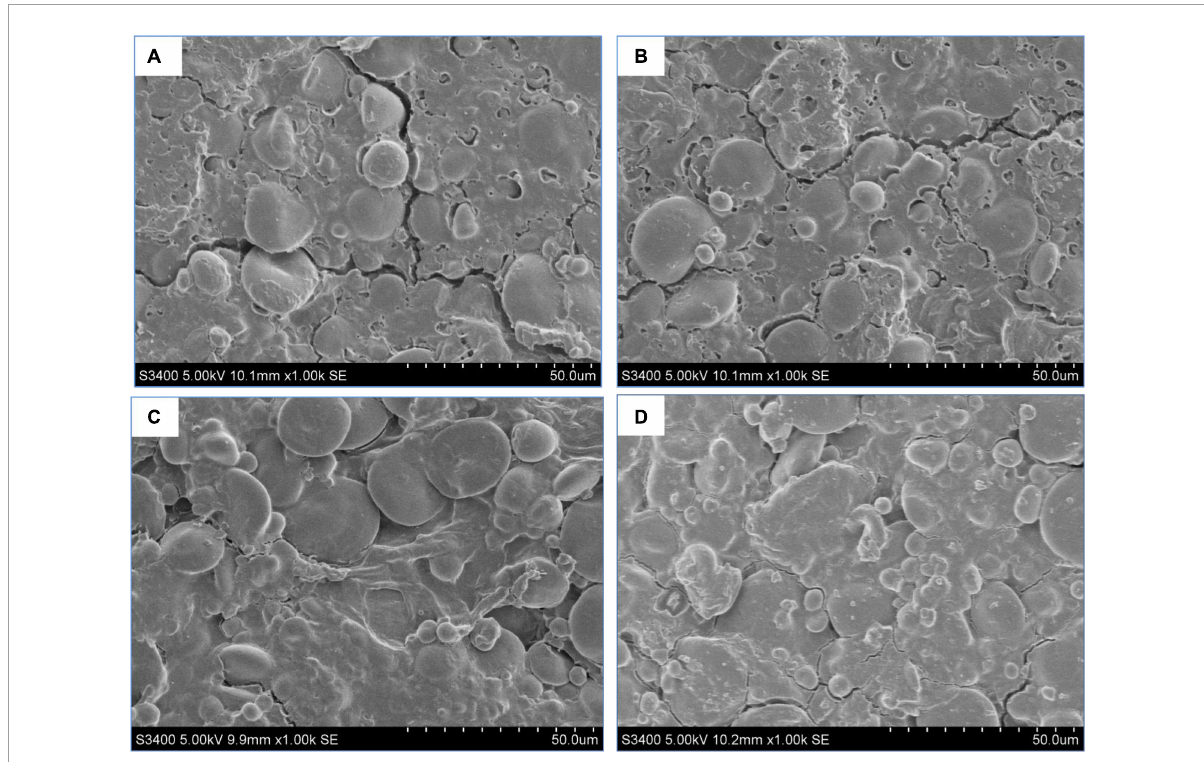
FIGURE5 Optical microscopic images of the microstructures of the dough treated with different MMBP amounts (0, 3, 6, and 9%). Original magnification: 1000x. (A) Wheat dough, (B) 3% MMBP-treated dough, (C) 6% MMBP-treated dough, and (D) 9% MMBP-treated